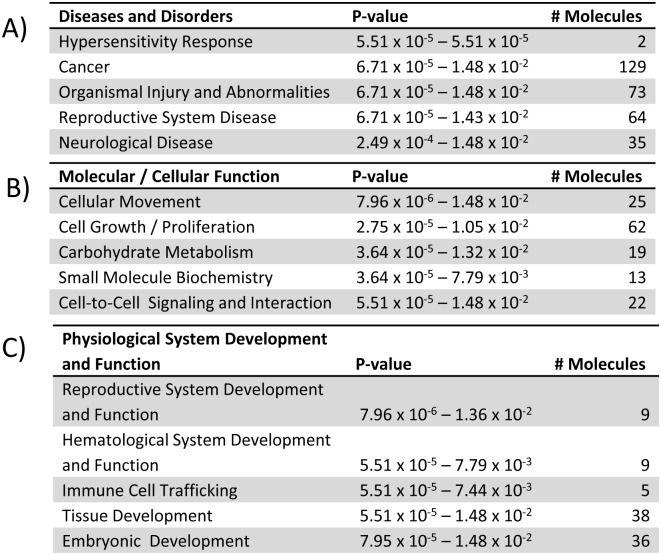
Top Networks and Functions proposed for genes whose differential expression is dependent on both aging and lack of AhR expression.203 genes which displayed differential expression dependent on both age and lack of AhR were analyzed using IPA to determine top Diseases and Disorders (A), Molecular and Cellular Functions (B), and roles in Physiological System Development and Function (C).